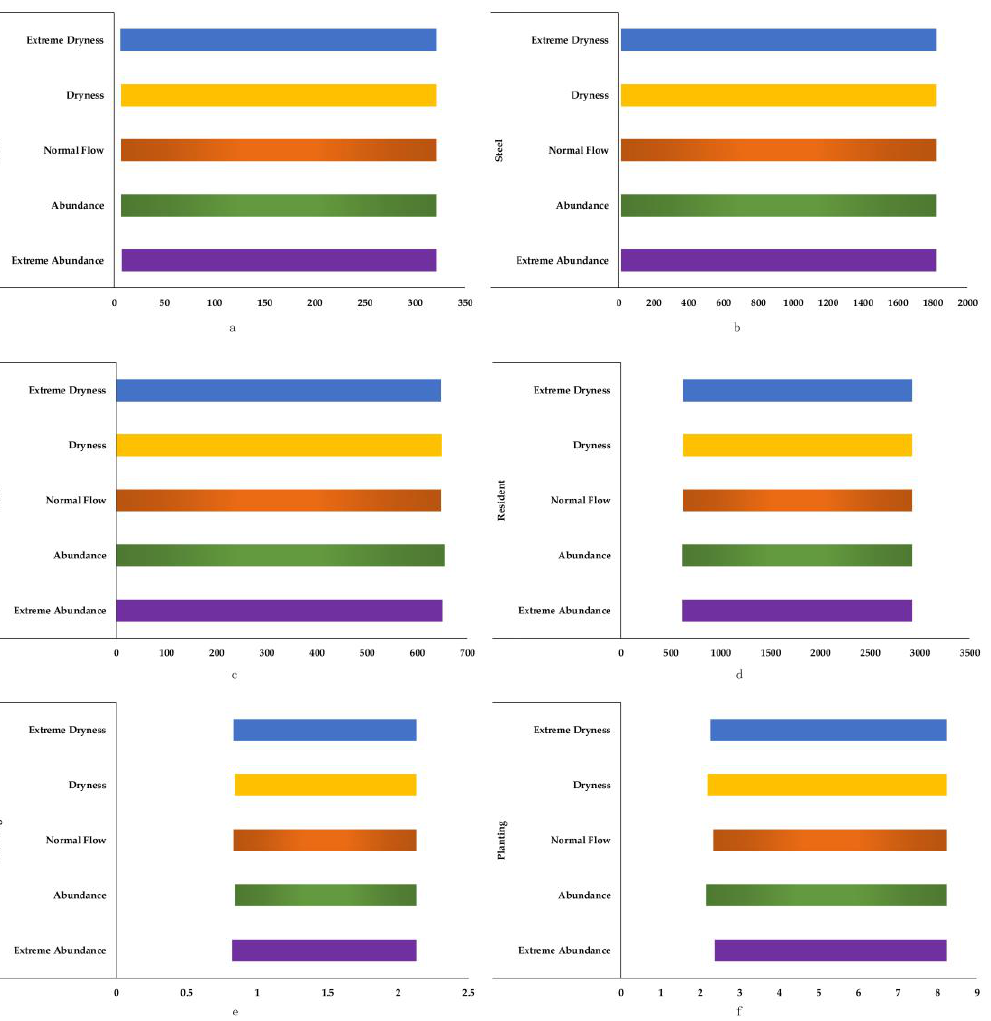
Figure 3. Penalty value of water resources in Liancheng County at the second stage (×10 4 t): ( a ) paper industry; ( b ) steel industry; ( c ) urban water; ( d ) domestic water; ( e ) water for farming; ( f ) water for planting (the second-stage penalty value is absent for cement, thermal power, and ecology).